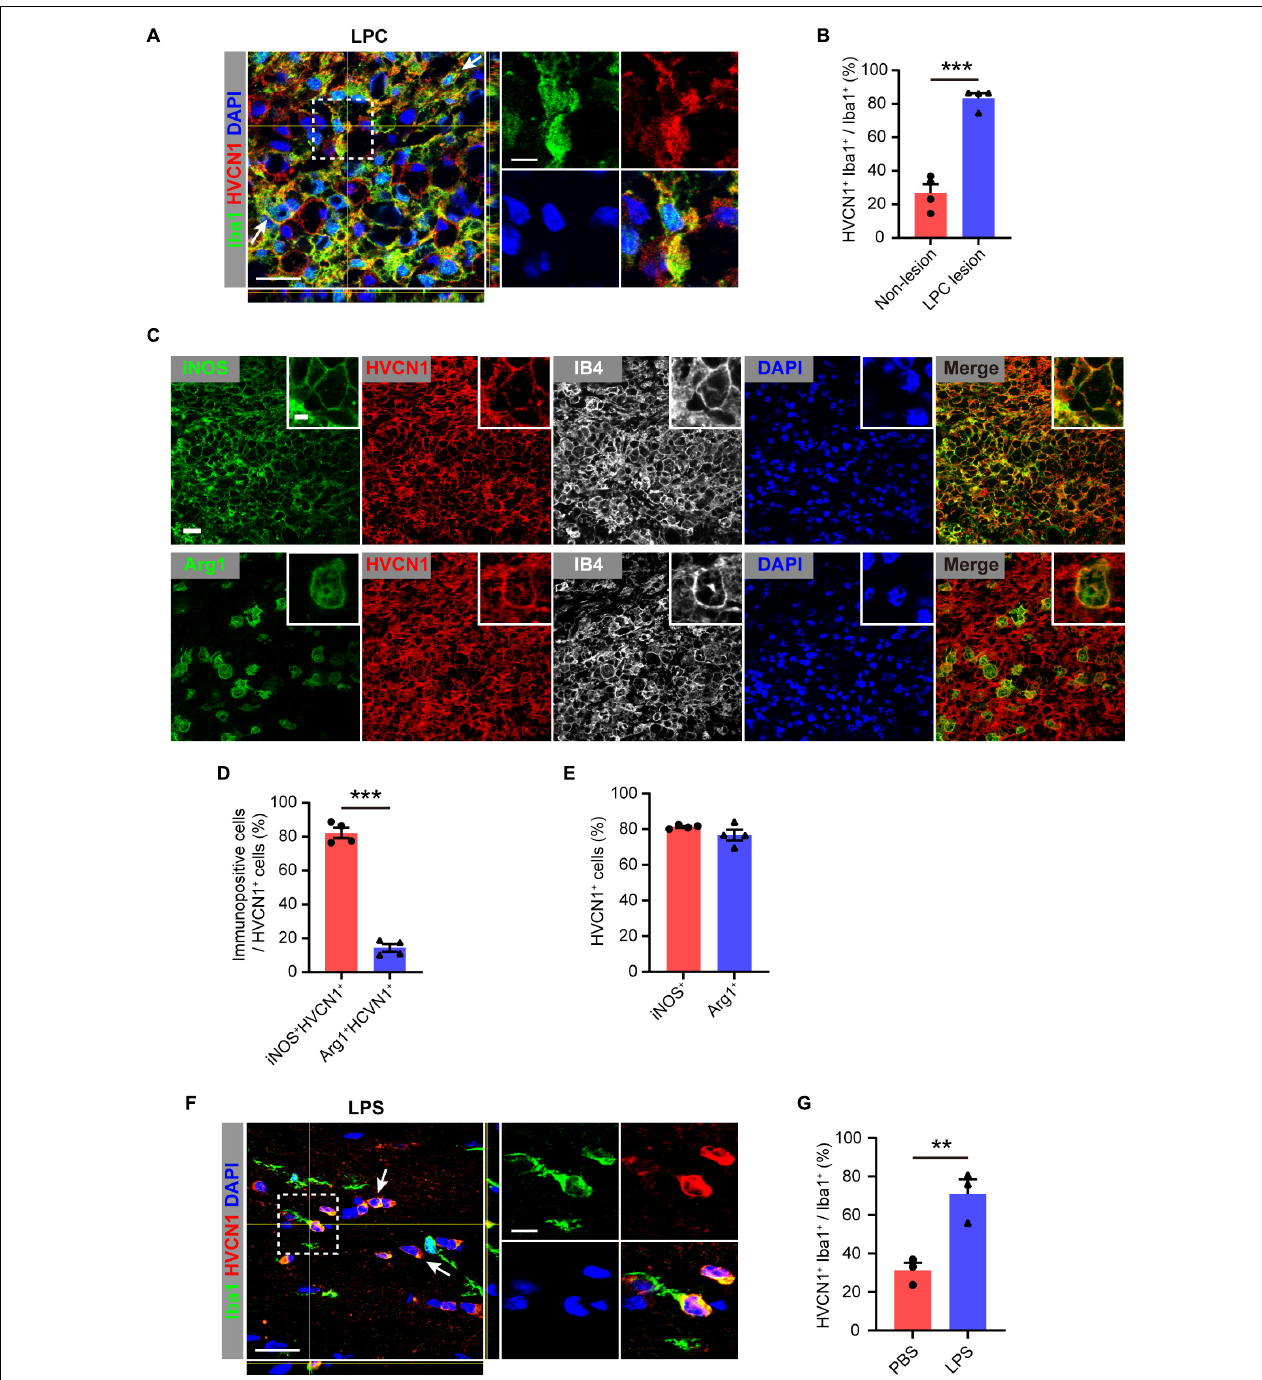
FIGURE 2 | Upregulation of HVCN1 in microglia/macrophage in multiple injuries. Representative immunofluorescence images (A) and quantification of the proportion (B) : HVCN1 (red) in Iba1 + (green) microglia/macrophages in focal demyelination lesion in corpus callosum of the mouse brain at 5 days after focal injection of lysolecithin (LPC). ( n = 4). Two HVCN1 + Iba1 + microglia are indicated as examples. (C) Immunofluorescence images show that HVCN1 (red) is expressed in both iNOS + (green, up) type and Arg1 + (green, down) type polarized IB4 + microglia/macrophages (gray). (D) The proportion of iNOS + and Arg1 + type microglia/macrophages in HVCN1 + cells ( n = 4/group). (E) The proportion of HVCN1 + cells in iNOS + and Arg1 + type microglia/macrophages ( n = 4/group). (F,G) Representative immunofluorescence images (E) and quantification of the proportion (F) : HVCN1 (red) in Iba1 + (green) microglia/macrophage in corpus callosum of mouse brain at 12 h after intraperitoneal (i.p.) injection of lipopolysaccharide (LPS). ( n = 3/group). Two HVCN1 + Iba1 + microglia are indicated as examples. Scale bars (A,C,E) = 20 µ m; the side length of the dashed-line square = 5 µ m. Data are presented as mean ± SEM. Statistical tests: unpaired two-tailed t -test (B,D,F) ; ** p < 0.01, *** p <